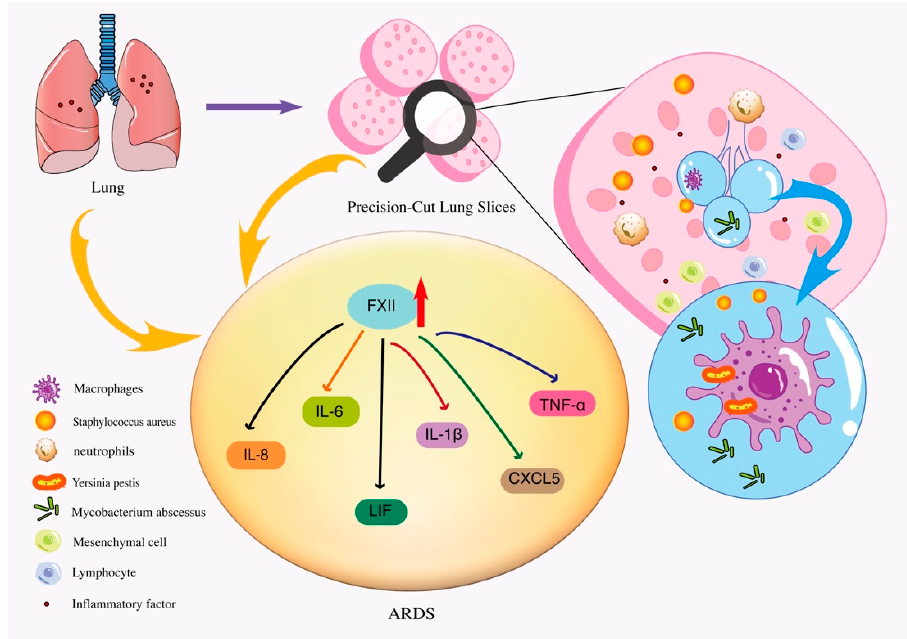
Figure 3. Inflammatory infiltrates in the alveolar space can be observed 24 to 48 h after Mycobacterium abscessus infection. Staphylococcus aureus is widely present in the epithelial and interstitial areas of hPCLSs, while the number of alveolar macrophages is small, which may not be targeted by macrophages during the development of pneumonia. Yersinia pestis is mainly phagocytosed by alveolar macrophages. In the ARDS model constructed on PCLSs, the endogenous coagulation FXII increases rapidly in the early stage of ARDS, which can promote the release of inflammatory factors such as interleukin (IL-8, IL-1 β , IL-6), LIF, CXCL5 and TNF- α on PCLSs. In simulating an injurious inflammatory response, PCLS disease models can be pre- pared in a specific region with preserved peripheral integrity. These models are simple